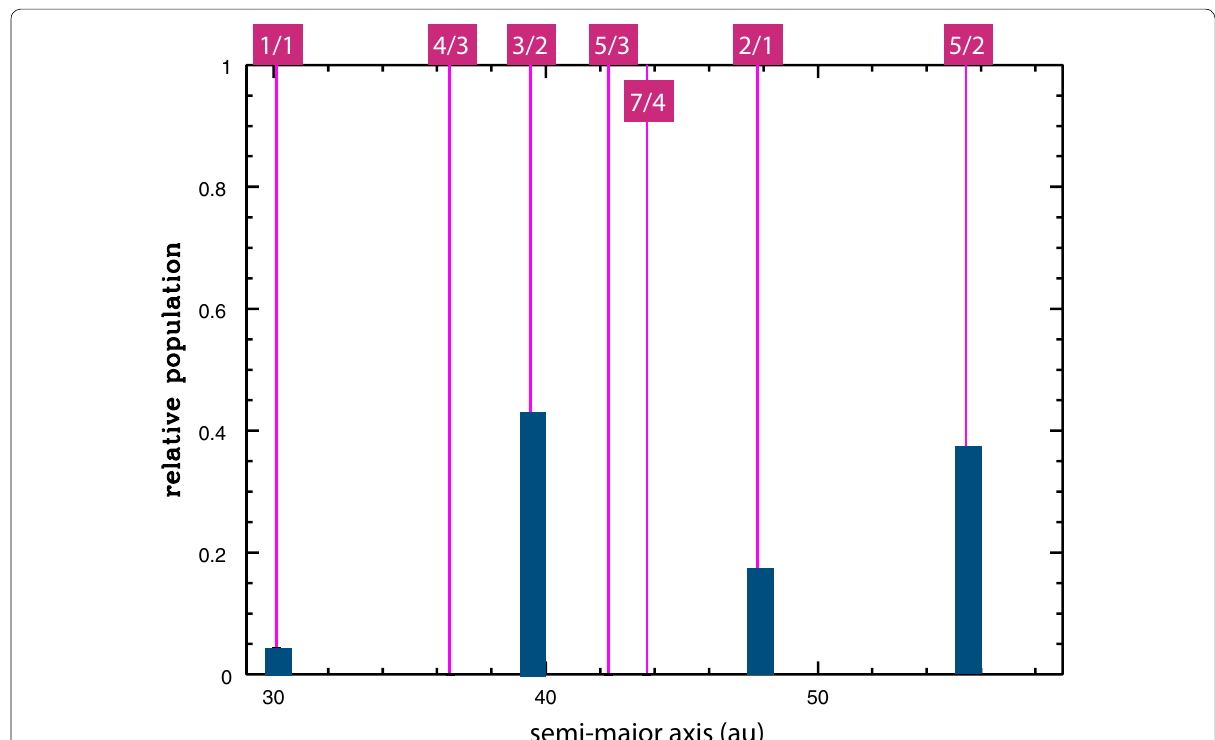
Fig. 3 The estimated intrinsic relative populations of resonant Kuiper belt objects. Only those resonances with published de-biased estimates are shown (Based on data from Volk et al.